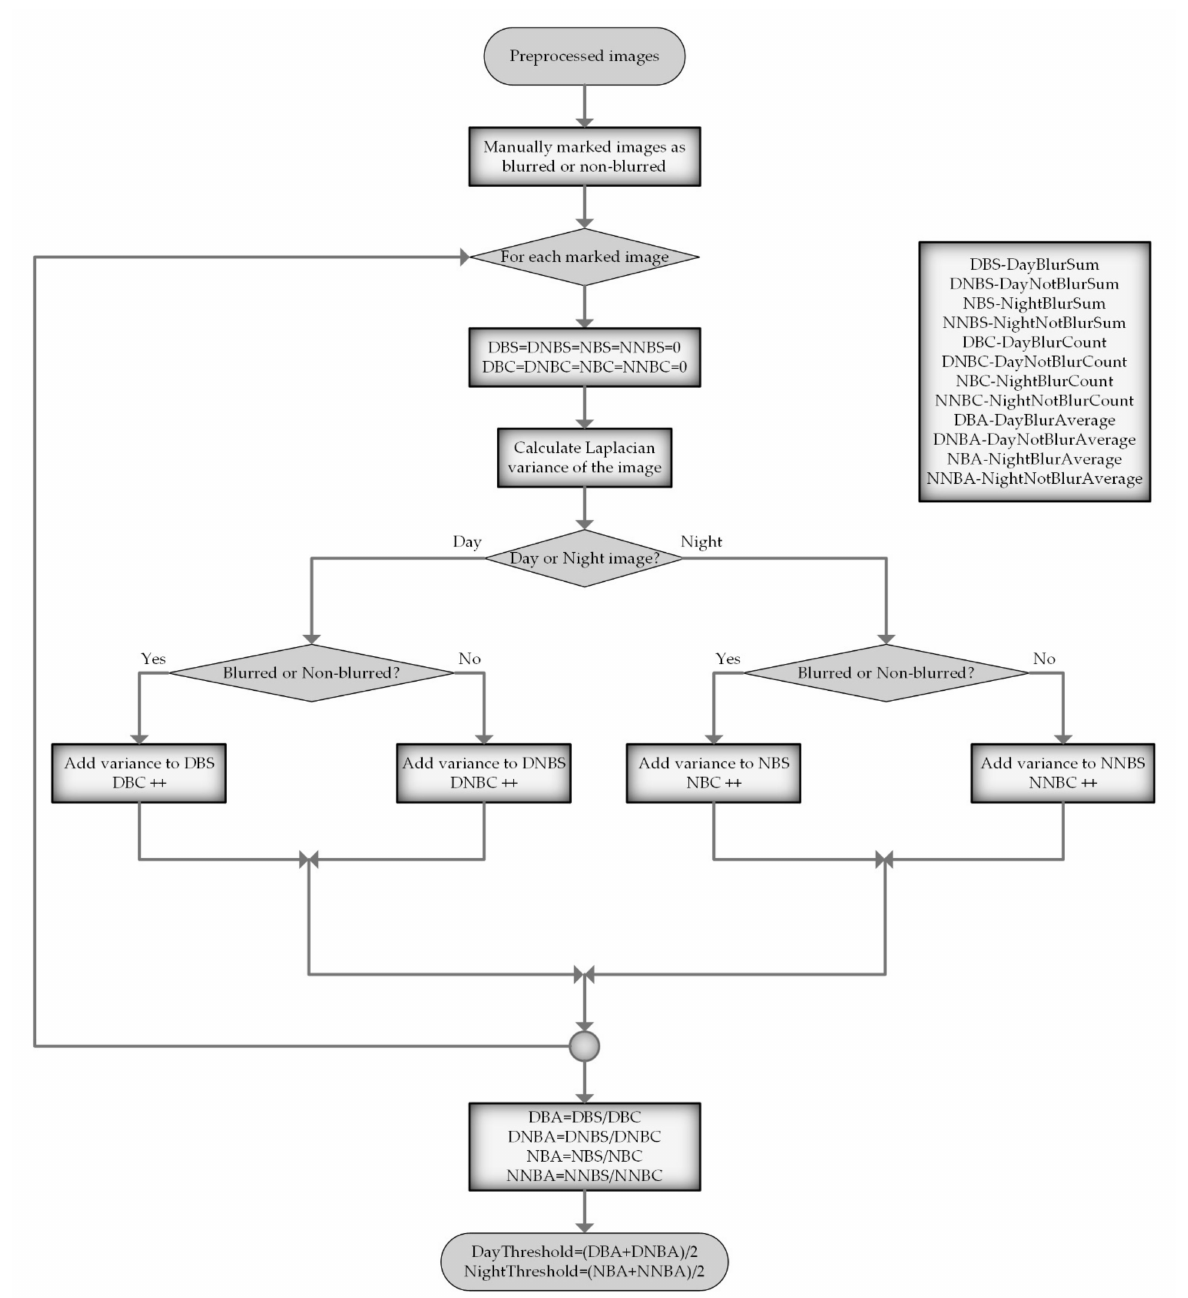
Figure 4. Threshold